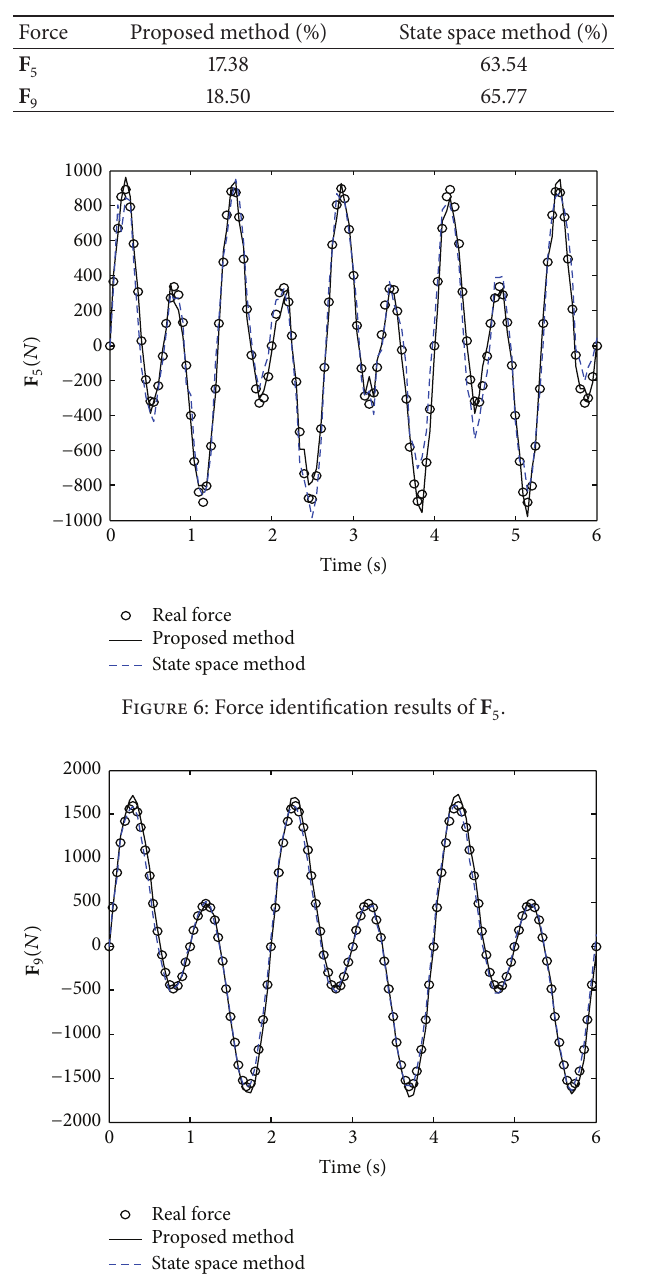
Figure 7: Force identification results of F 9 .